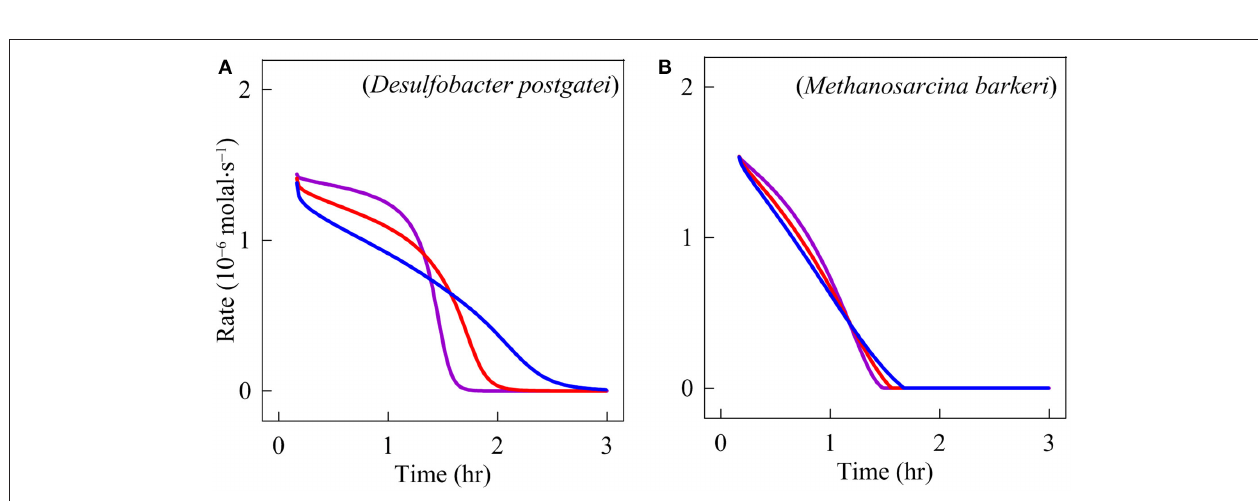
FIGURE 2 | Variation with time in respiration rates of Desulfobacter postgatei (A) and Methanosarcina barkeri (B) . The lines are the simulation results at pH 7 (blue), 6 (red), and 5